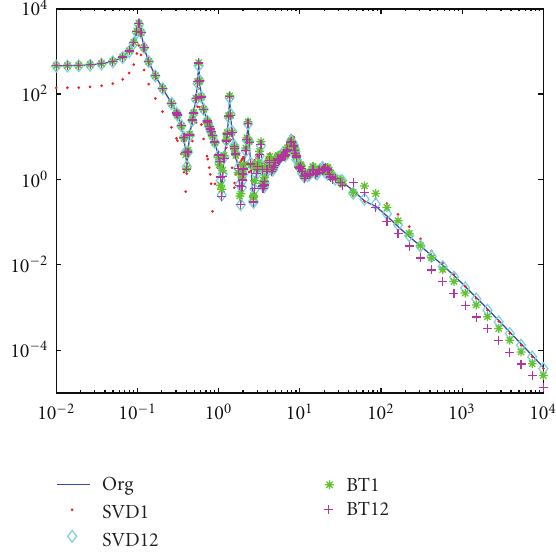
Figure 1: Frequency response on clamped beam model with size n = 174 and the reduced model of size r = 20 by four di ff erent methods.